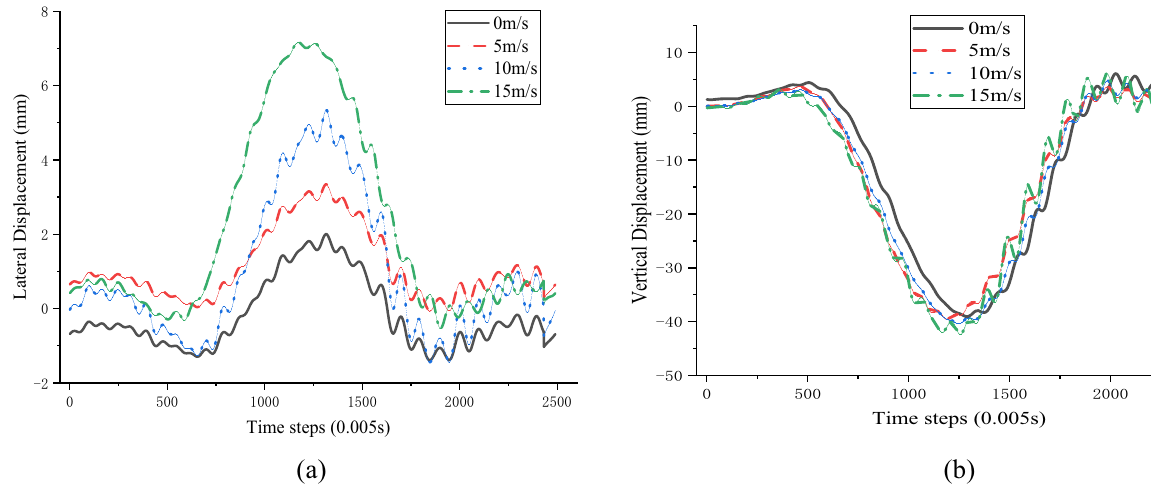
Fig. 10 Time histories of displacements. a lateral displacement; b vertical displacement